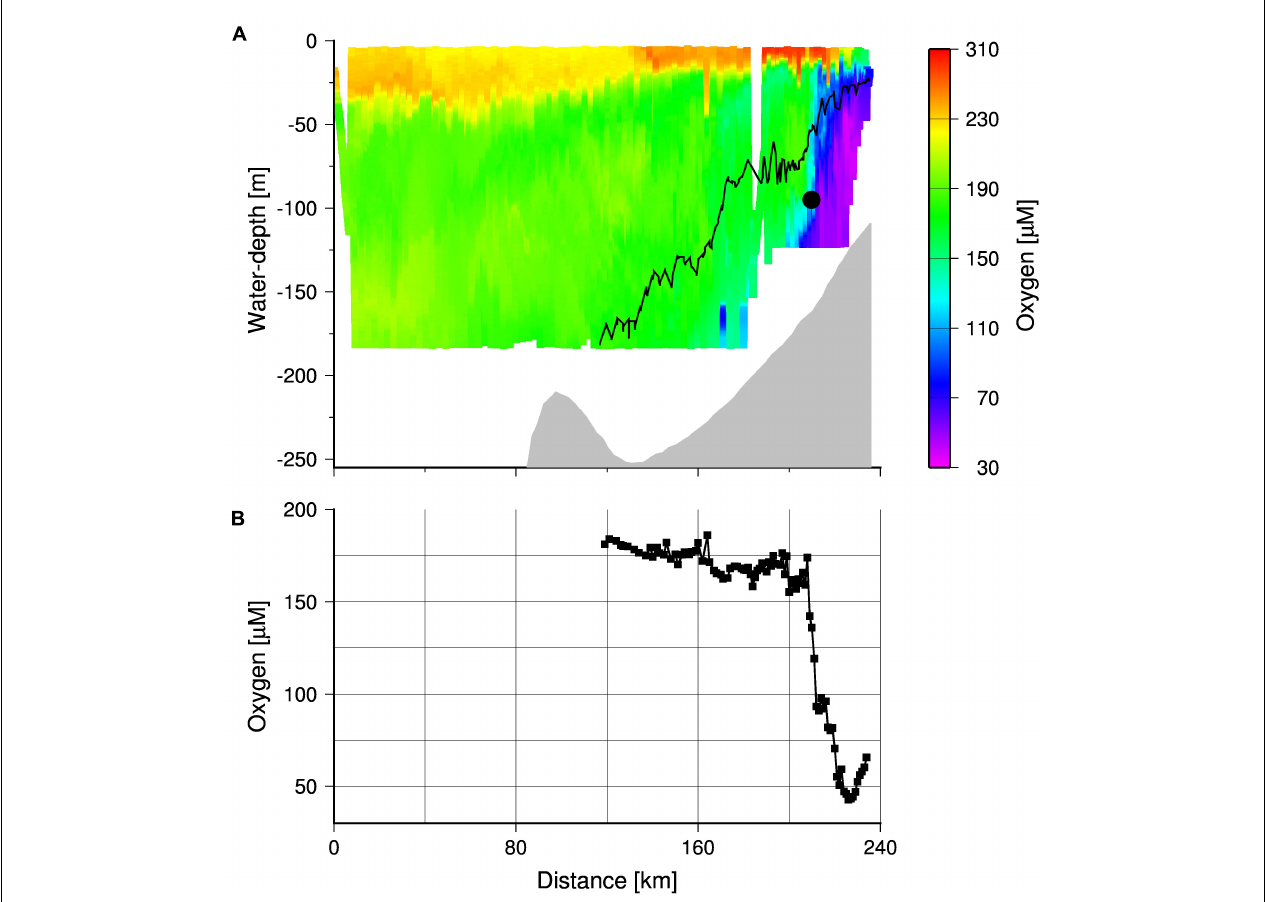
FIGURE 10 | (A) TRIAXUS transect showing the cross-shelf distribution of dissolved oxygen. The gray shading the bottom and black contour line shows the density isopleth 26.6 kg m − 3 , which separates the MUW and SAMW. The black circle indicates the position of the MDO sensor. (B) Dissolved oxygen concentrations averaged within density range of 26.6–26.9 kg m − 3 along the transect. The coast is located at kilometer